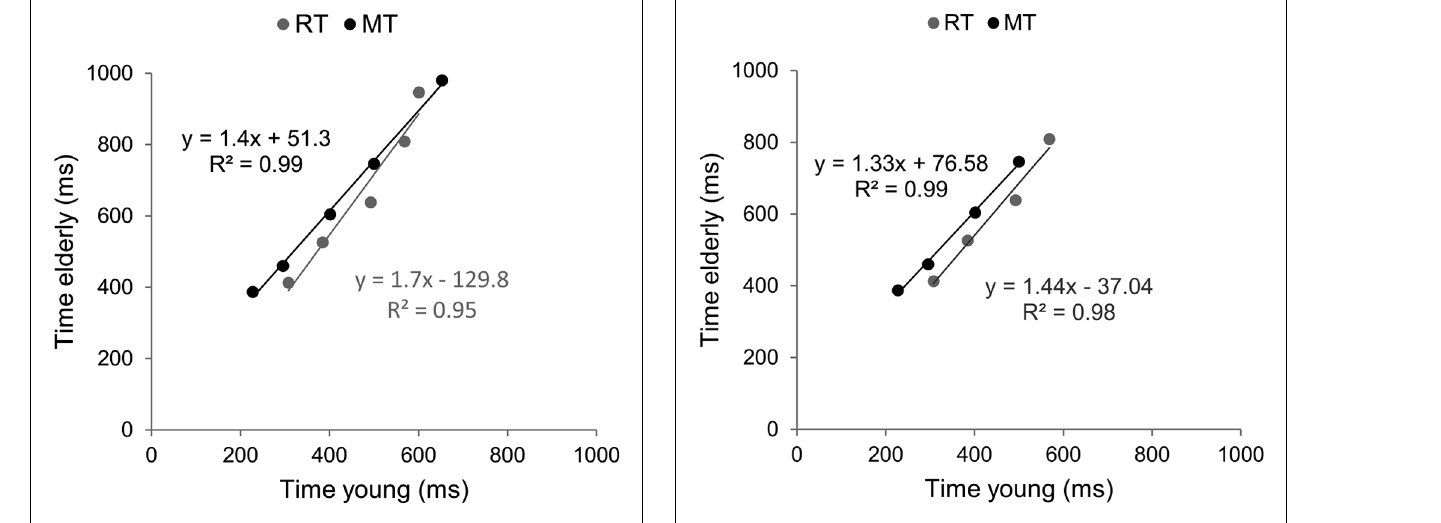
FIGURE 3 | Brinley plots. Data and linear regression estimates of reaction time (observed in Hick–Hyman’s task) are presented in gray and those of movement time (observed in Fitts’ task) are presented in black. Each data point corresponds to an ID condition (from the easiest to the hardest).